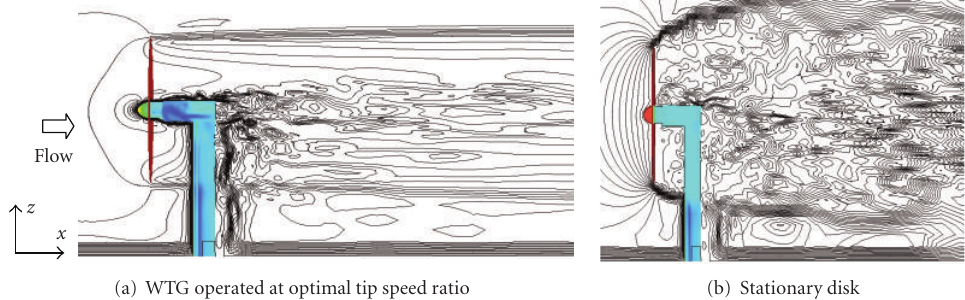
Figure 8: Enlarged view of Figure 6. The colors on the spinner, nacelle, and tower represent the dynamic surface pressure. Blue and red indicate the minimum (negative) and maximum values.